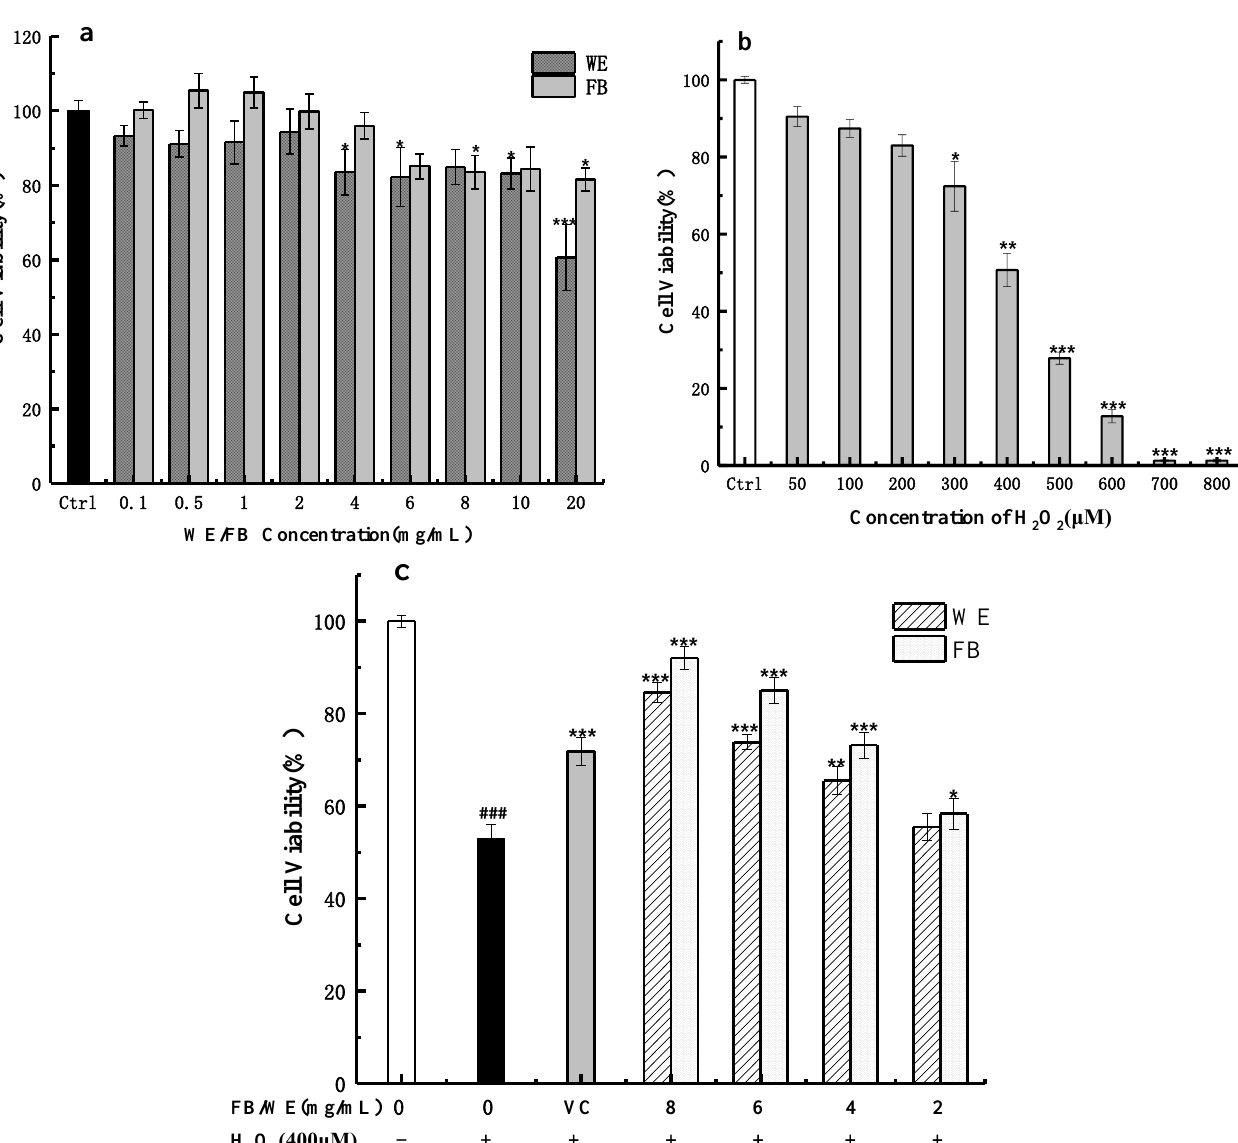
Figure 5. Effects of WE and FB on H 2 O 2 -introduced HaCaT cells damage. ( a ) Cytotoxicity of WE and FB on HaCaT cells. The HaCaT cells were cultured for 24 h with the WE and FB of 20, 10, 8, 6, 4, 2, 1, 0.5 and 0.1 mg/mL, and then, the cell viability was measured by a CCK-8 assay. Significance: *** p < 0.001 and * p < 0.05 vs. the control group. ( b ) Cytotoxicity of different concentrations of H 2 O 2 on HaCaT cells. The HaCaT cells were cultured in complete medium for 24 h and then stimulated with different concentrations (50, 100, 200, 300, 400, 500, 600, 700 and 800 µ M) of H 2 O 2 for 2 h, and then, the cell viability was measured by the CCK-8 assay. Significance: *** p < 0.001, ** p < 0.01 and * p < 0.05 vs. the control group. ( c ) Cytotoxicity of the WE and FB on 400 µ M H 2 O 2 -introduced HaCaT cell damage. The cells were cultured with different concentrations (8, 6, 4 and 2 mg/mL) of WE and FB for 24 h and then stimulated by 400 µ M H 2 O 2 for 2 h, and then, the cell viability was measured by the CCK-8 assay. In the picture: VC stands for Vitamin C, and the concentration is 2 µ g/mL. Significance: ### p < 0.001 vs. the control group. *** p < 0.001, ** p < 0.01 and * p < 0.05 vs. the H 2 O 2 -treated group. Data shown as the mean ± S.D. ( n = 5).